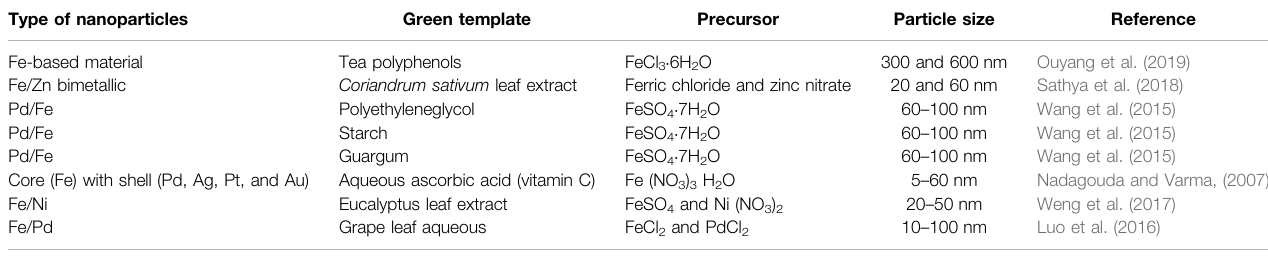
TABLE 1 | Biological and biogenic syntheses for preparing Fe NPs. Type of nanoparticles